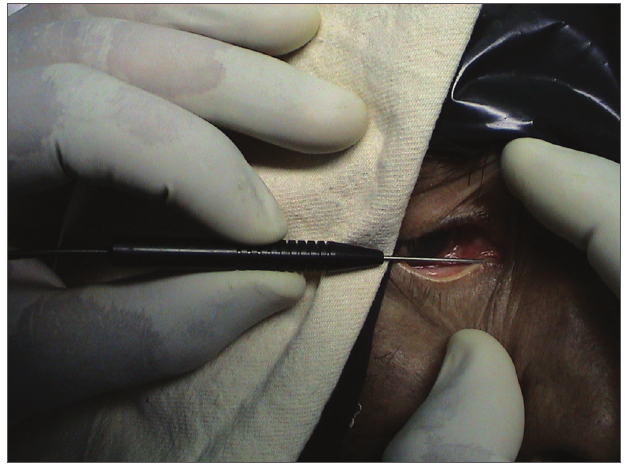
Figura 2. Introdução do feixe de fibra óptica no canalículo lacrimal inferior.